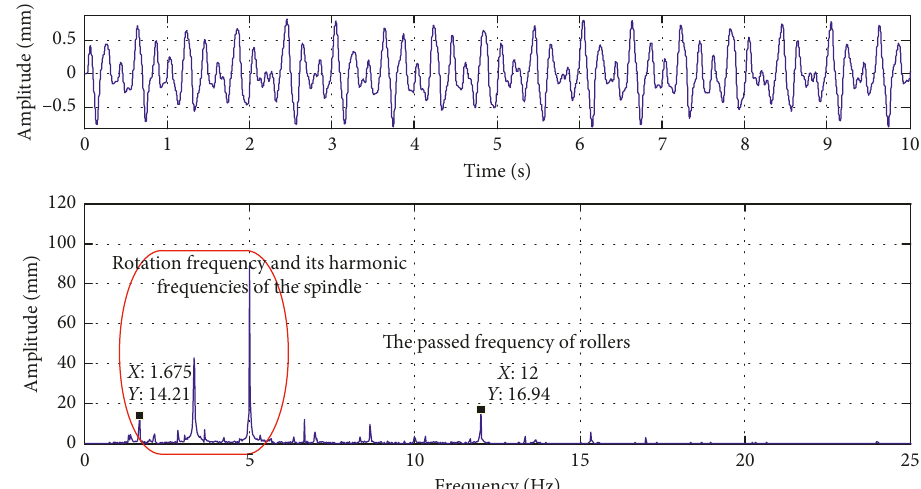
Figure 14: The time-domain diagram and the spectrum diagram of the cylindrical roller bearing with bruise on the inner raceway.